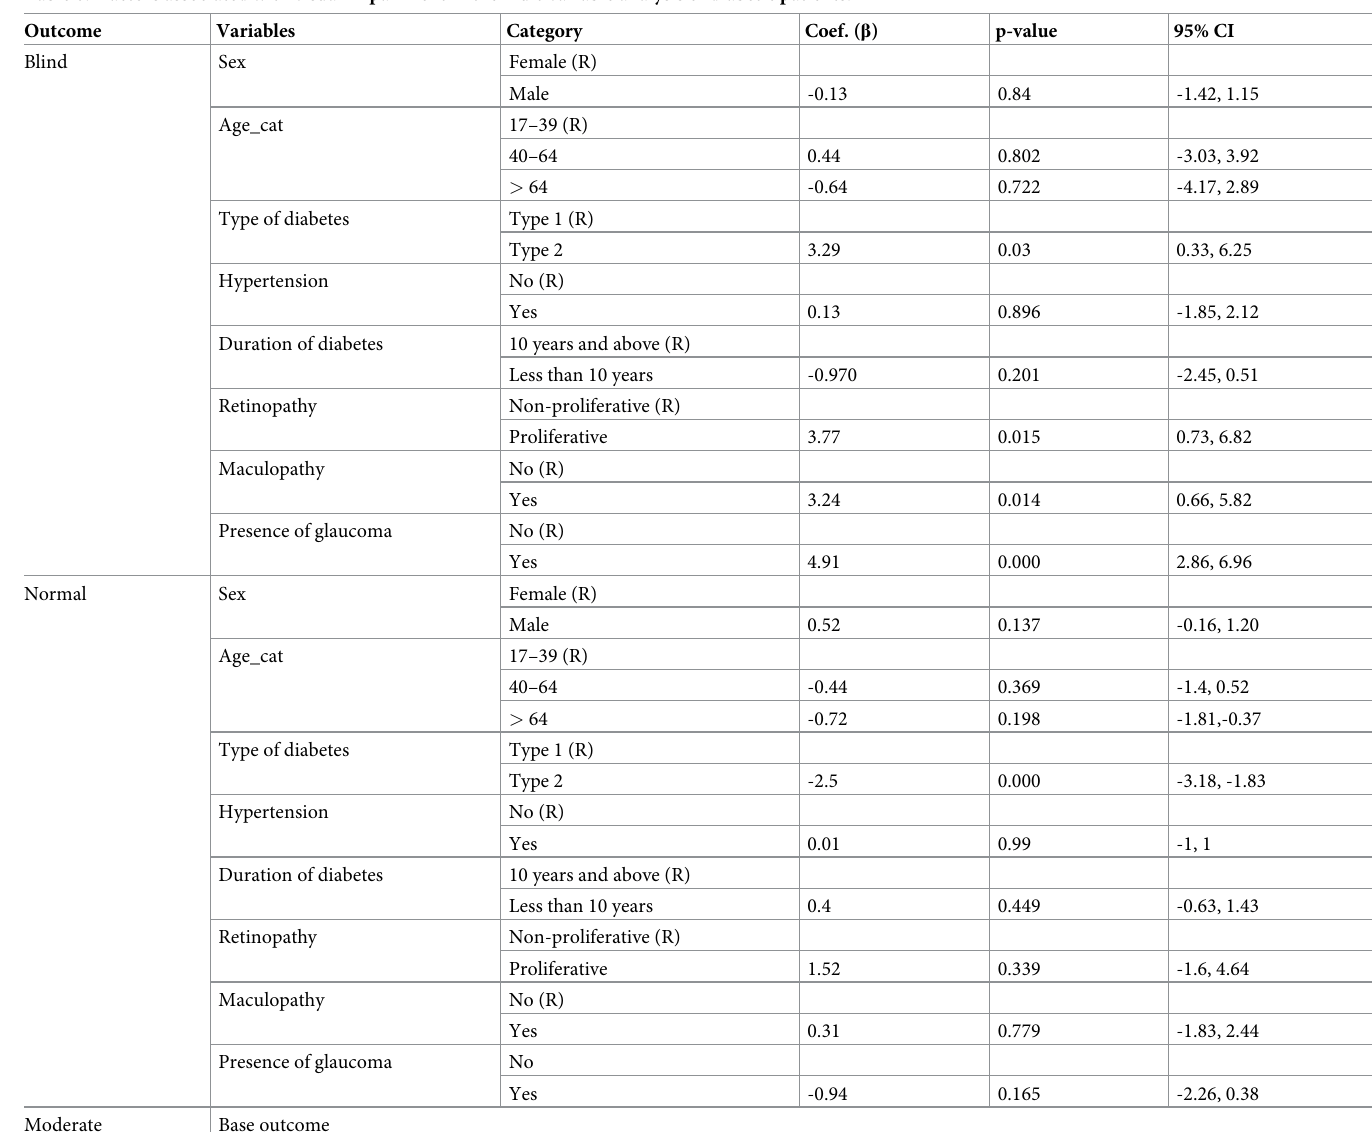
Table 6. Factors associated with visual impairment in the multivariable analysis of diabetic